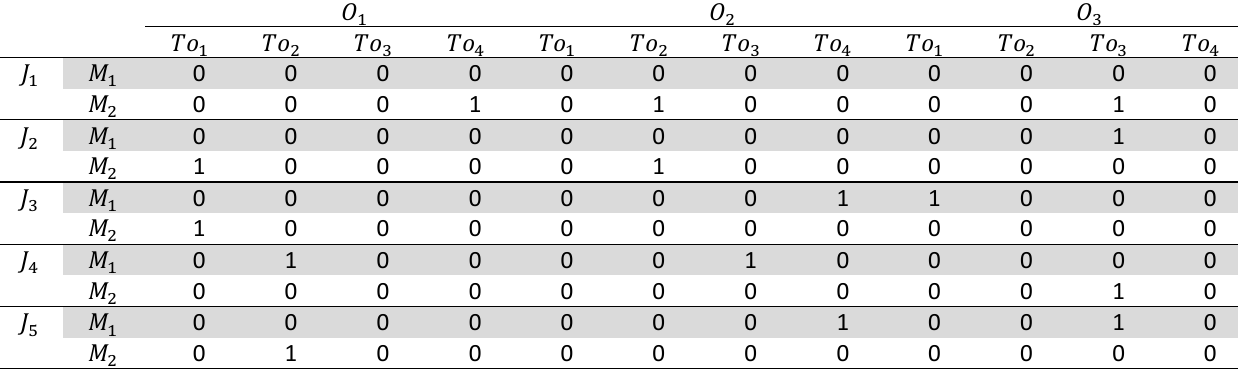
Loading of machines in